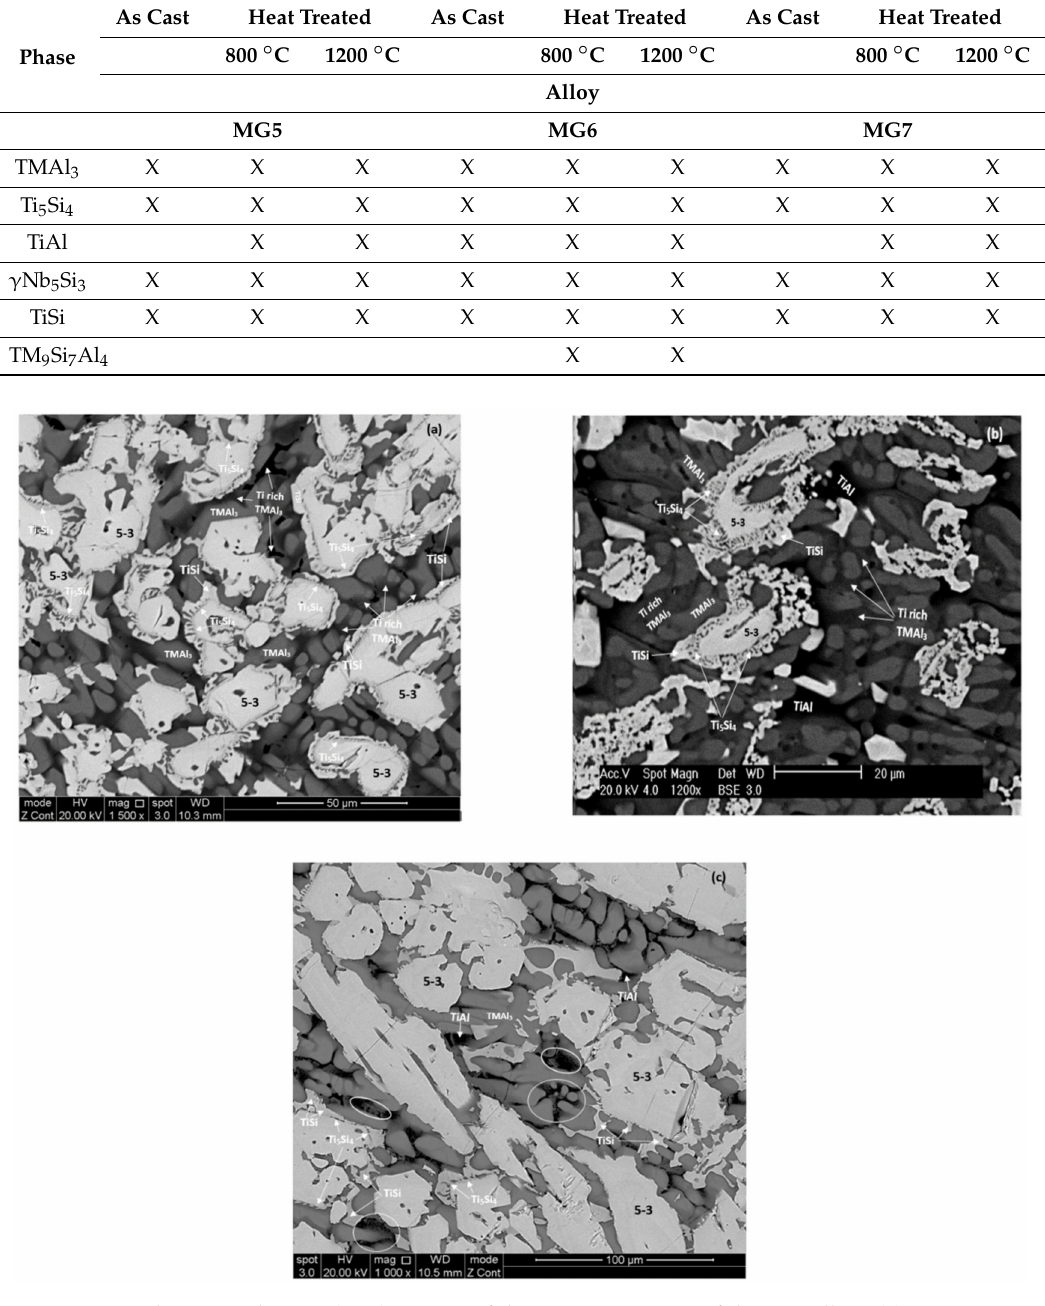
Figure 3. Back scatter electron (BSE) images of the microstructures of the cast alloys ( a ) top—MG5, ( b ) and ( c ) respectively bottom and bulk of the alloy MG6. For the encircled areas see